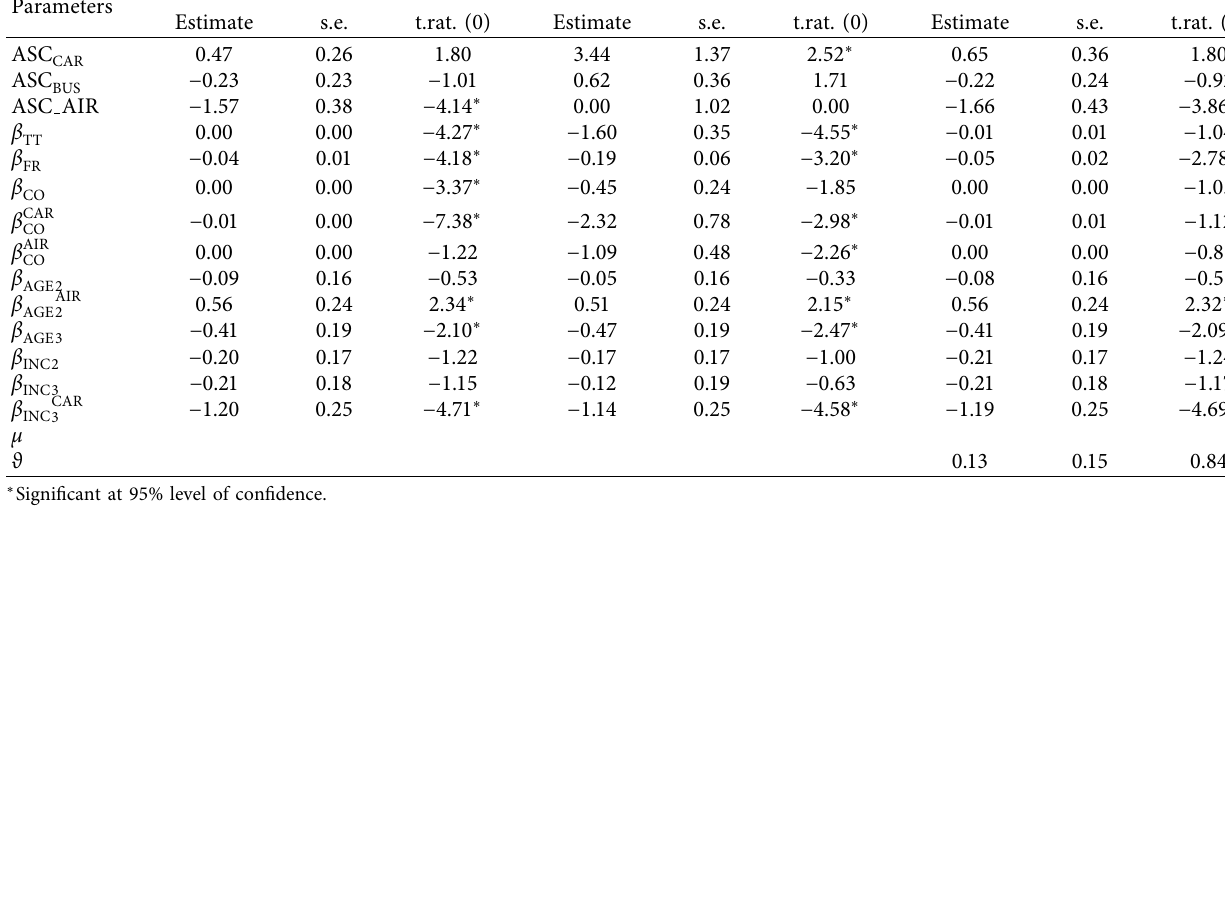
Table 12: Estimates of the CRRM, PLW, and PLGW for nonbusiness purpose of the HSR experiment.